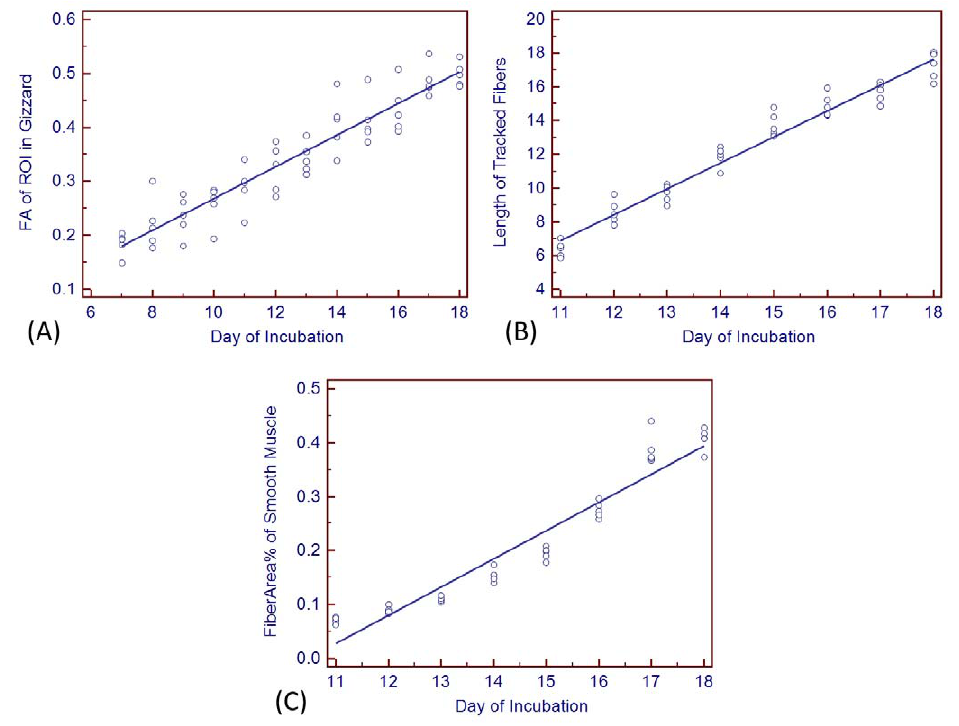
Figure 1. Scatter plots of measured smooth muscle parameters vs. incubation day. ( A ) Relationship between DTI-derived fractional anisotropy (FA) and incubation day. ( B ) Relationship between histology-derived FiberArea% and incubation day. ( C ) Relationship between length fibers tracked with DTI and incubation day. For all figures, the trend line indicates the result of linear regression analysis.